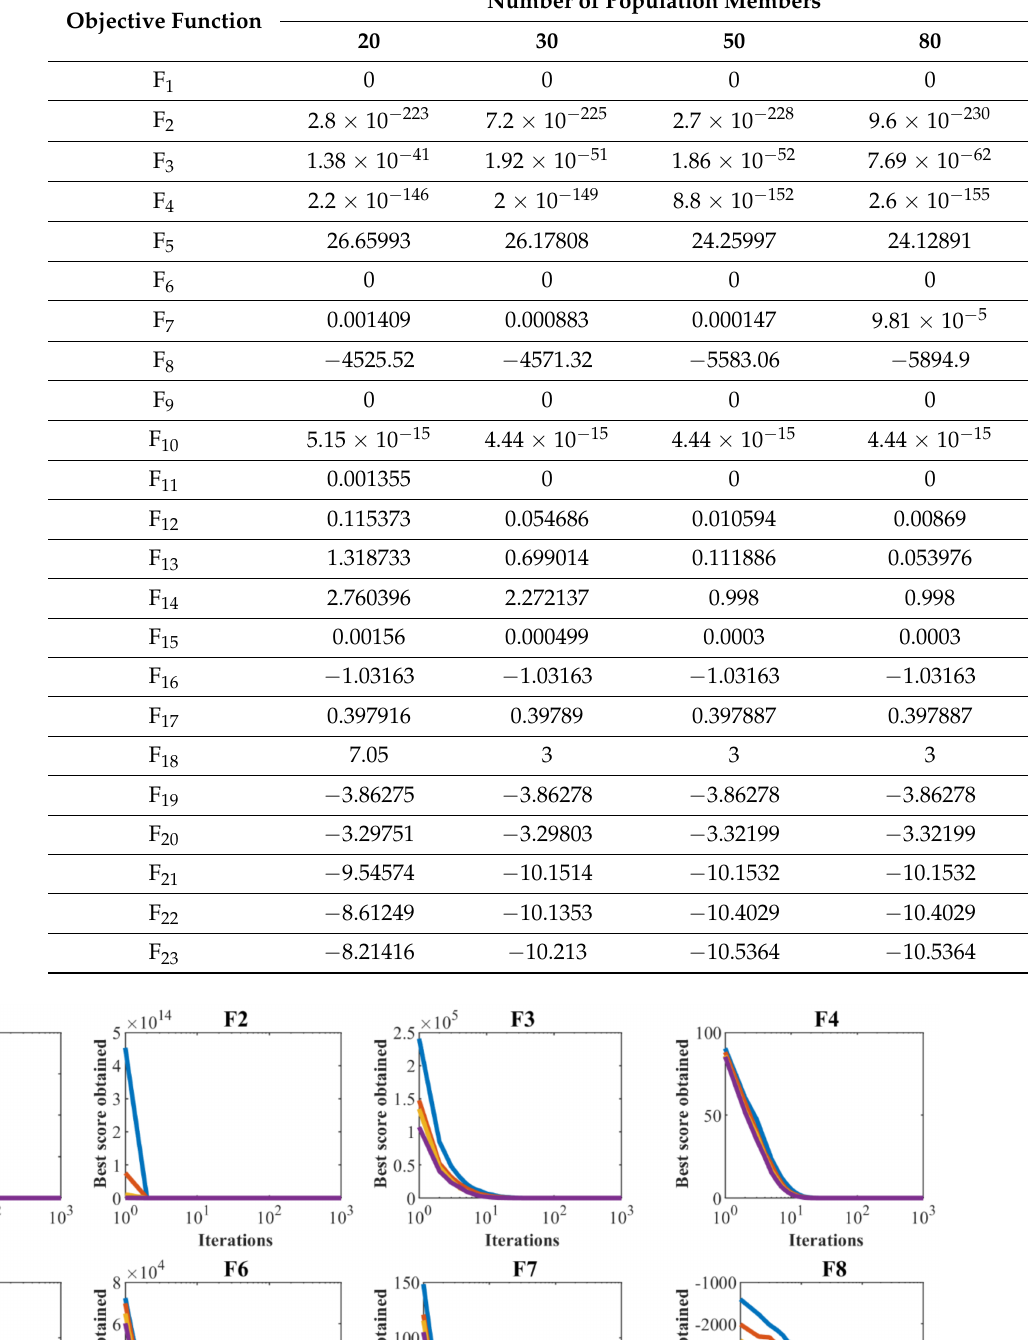
Table 7. Results of the algorithm sensitivity analysis to the number of population members.